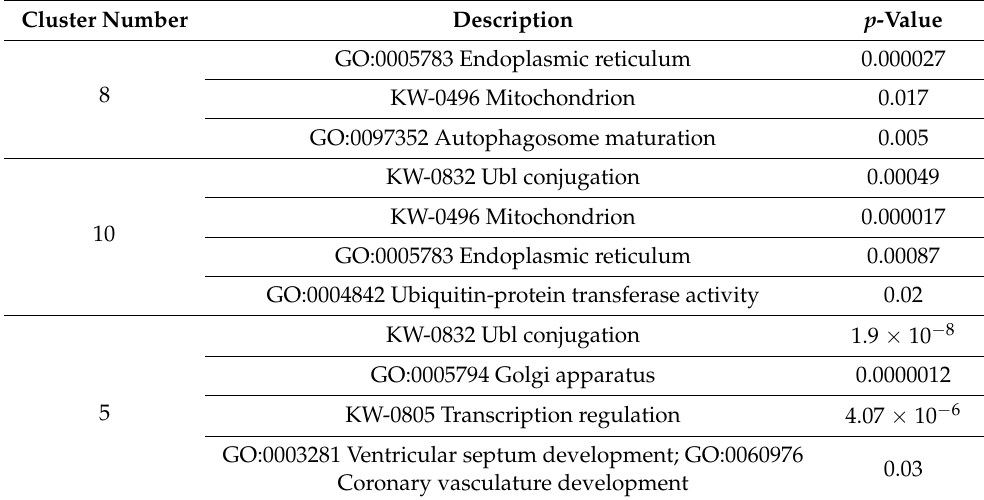
Table 1. Summary of enrichment scores for gene clusters identified by SOTA algorithm. Data described in the table were retrieved using the DAVID database. GO indicates the Gene Ontology number, while KW stands for keywords used in the UniProt